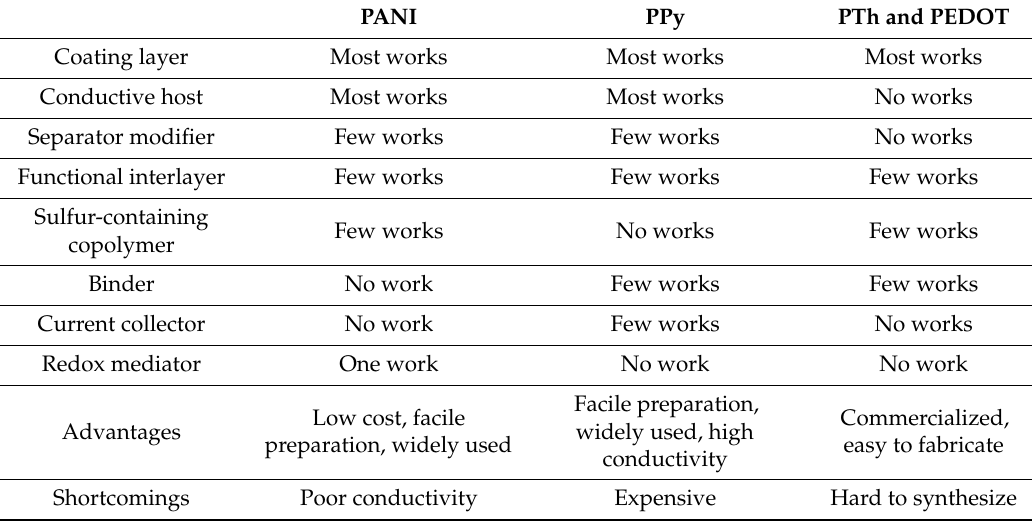
Table 4. The comparison of three conducting polymers in Li-S batteries. PANI PPy PTh and PEDOT Most works Most works Most works Most